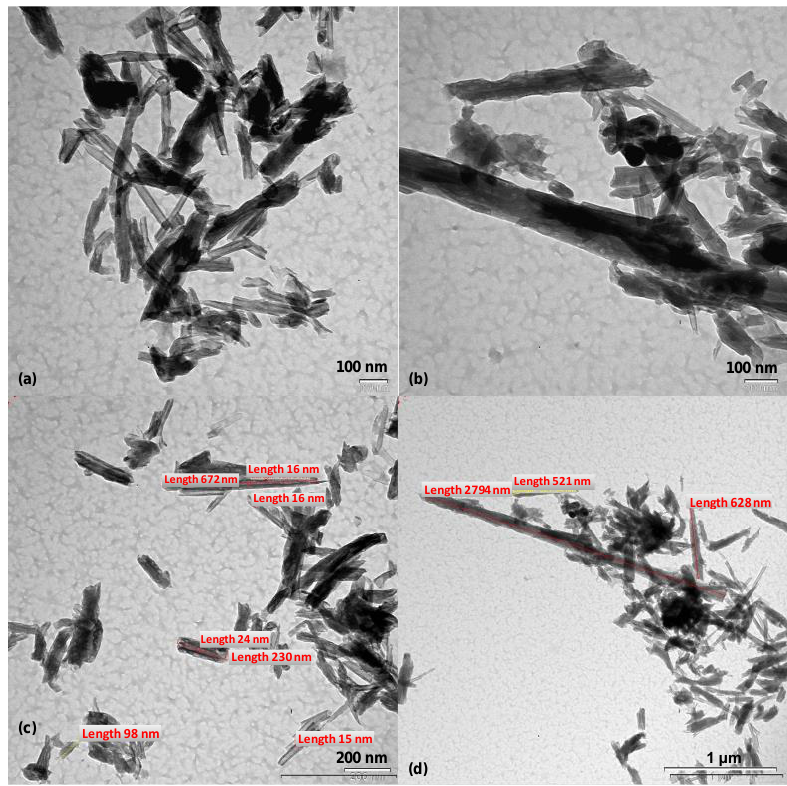
Figure 2. TEM images of halloysite nanotubes ( a ) and ( b ) 100 nm, ( c ) 200 nm, and ( d ) 1 µm. Well-crystallized kaolinites consisted of particles with morphologically well-defined hexagonal-shaped pinacoid {001} faces. The hexagonal surfaces of the particles correspond to 001 basal planes in the crystallographic view. While the axial dimensions of the kaolin- ite particles were different from each other, the surface dimensions of the particles were greater than their thickness. In this state, kaolinites were arranged as platelets. The typical size of kaolinite particles ranged from 0.2 to 4 μm in diameter, but very small particles have also been described in the literature [24]. Figure 3a shows the TEM image of the lamellar kaolinite mineral in which the hexagonal morphology was clearly defined. With the BET analysis method, the surface area of the kaolinite mineral was measured as 15.6 m 2 /g. In the TEM image of the quartz mineral, the quartz particles appeared to have basic structural units (Figure 3b).